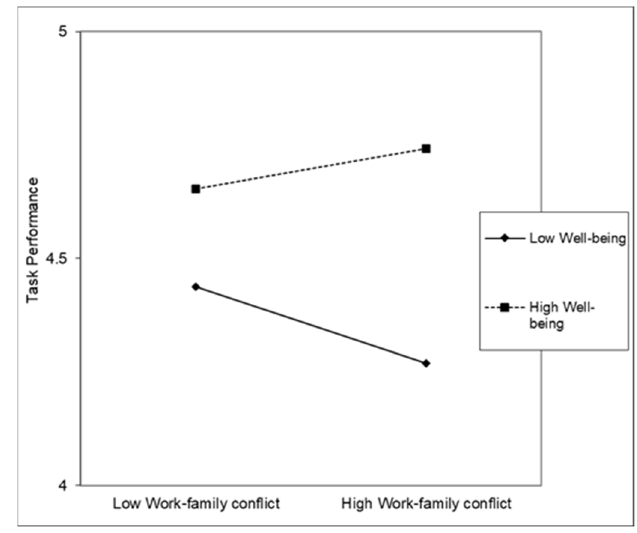
Figure 11. WFC x Well-being interaction chart.